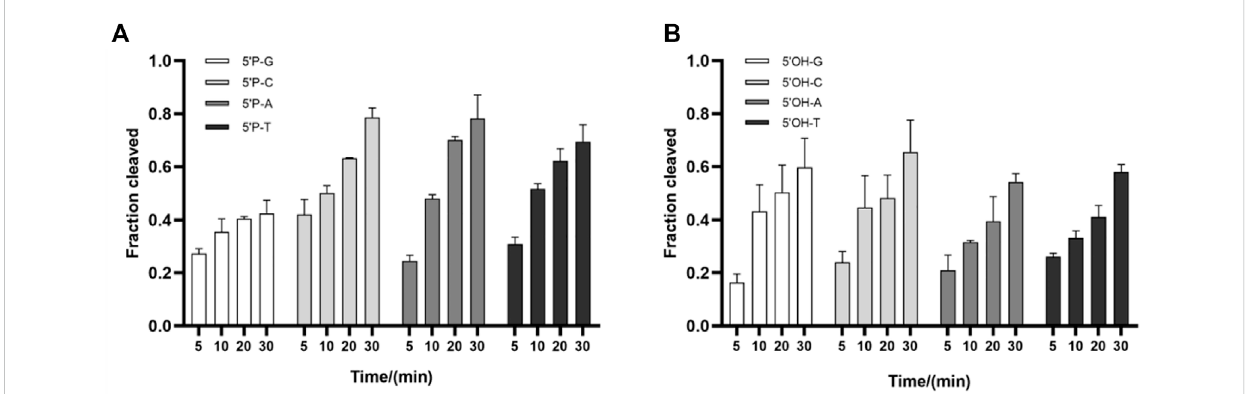
FIGURE 4 Effectsofthe5 ′ -end-nucleotideoftheguideandguide – target mismatches ontargetcleavage. (A) Preferencesforthe5 ′ -end-nucleotideofthe5 ′ - P-gDNA on DNA cleavage activity. (B) Preferences for the 5 ′ -end-nucleotide of the 5 ′ -OH-gDNA on DNA cleavage activity. All experiments were performed with Ttd Ago, guide, and target at the molar ratio of 4:4:1 (800 nM Ttd Ago preloaded with 800 nM guide, plus 200 nM target) in a reaction buffer containing 5 mM Mn 2+ at 75 ° C.